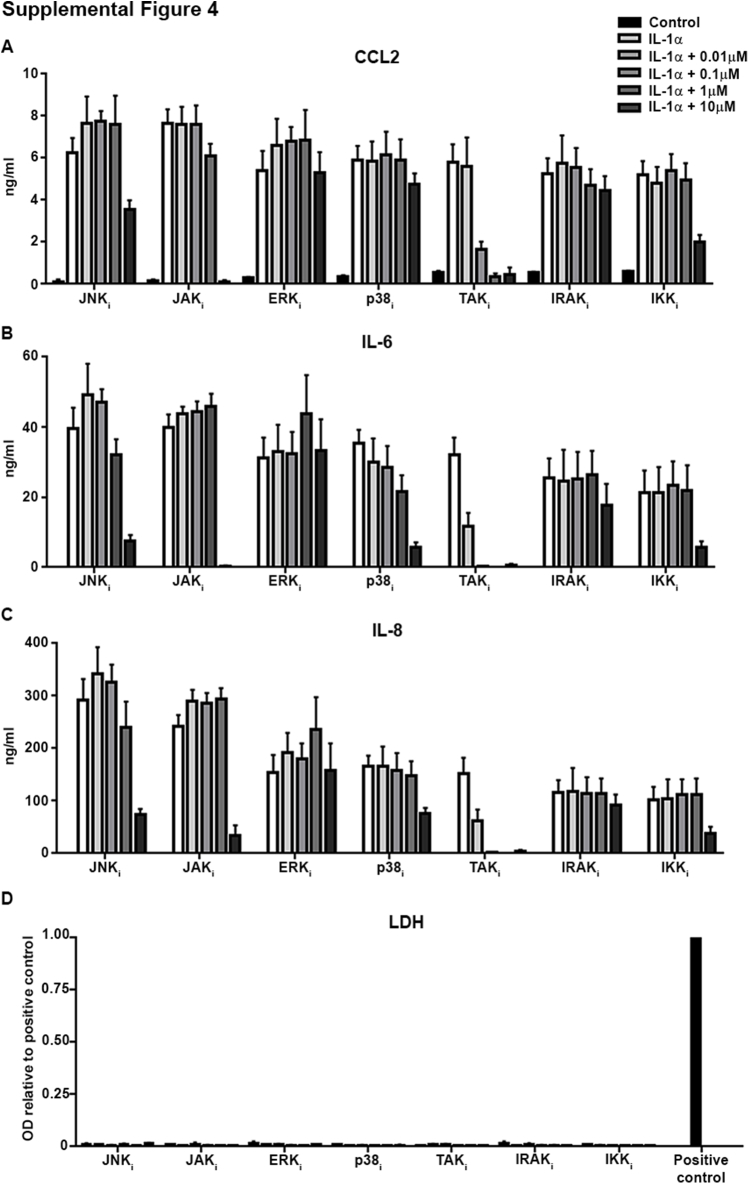
Targeting key intracellular signaling pathways in fibroblasts blocks cytokine secretion. Fibroblasts isolated from the infrapatellar fat pad of patients undergoing primary total knee arthroplasty were pretreated for 1 hour with increasing doses (0.01 to 10 μmol/L) of several selective inhibitors before stimulation with 500 pg/mL IL-1α for 24 hours. The secretion of CCL2 (A), IL-6 (B), and IL-8 (C) was quantified by enzyme-linked immunosorbent assay, and the release of lactate dehydrogenase (D) was quantified using a Pierce LDH Cytotoxicity Assay Kit. Data are presented as means ± SEM. n = 6 (A–D). ERK, extracellular signal–regulated kinase; IKK, Iκ B kinase; IRAK, IL-1 receptor associated kinase; JAK, Janus activating kinase; JNK, c-Jun N-terminal kinase; TAK, transforming growth factor β–activated kinase.